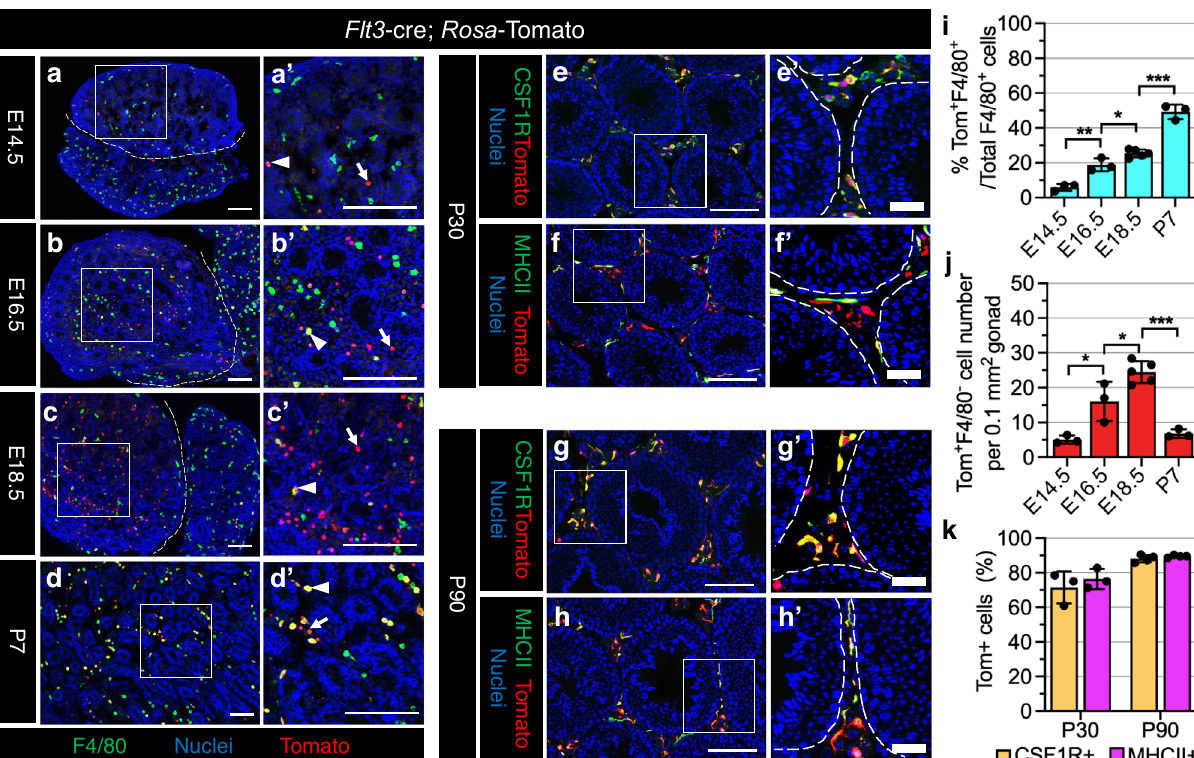
Fig. 3 | Flt3-expressing fetal HSC-derived multipotent progenitors give rise to adult testicular macrophages. a – h Representative images ( n =3 independent gonads) of Flt3 -cre; Rosa -Tomato testes at E14.5 ( a ), E16.5 ( b ), E18.5 ( c ), P7 ( d ), P30 ( e , f ), and P90 ( g , h ).Arrowheads denote Tomato-expressing F4/80 + macrophages and arrows denote Tomato-expressing F4/80-negative cells. Thin scale bar, 100 μ m; thick scale bar, 25 μ m. i – k Graphs showing quanti fi cation of percent Tomato-expressing F4/80 + macrophages ( i ),number of Tomato-expressing F4/80-